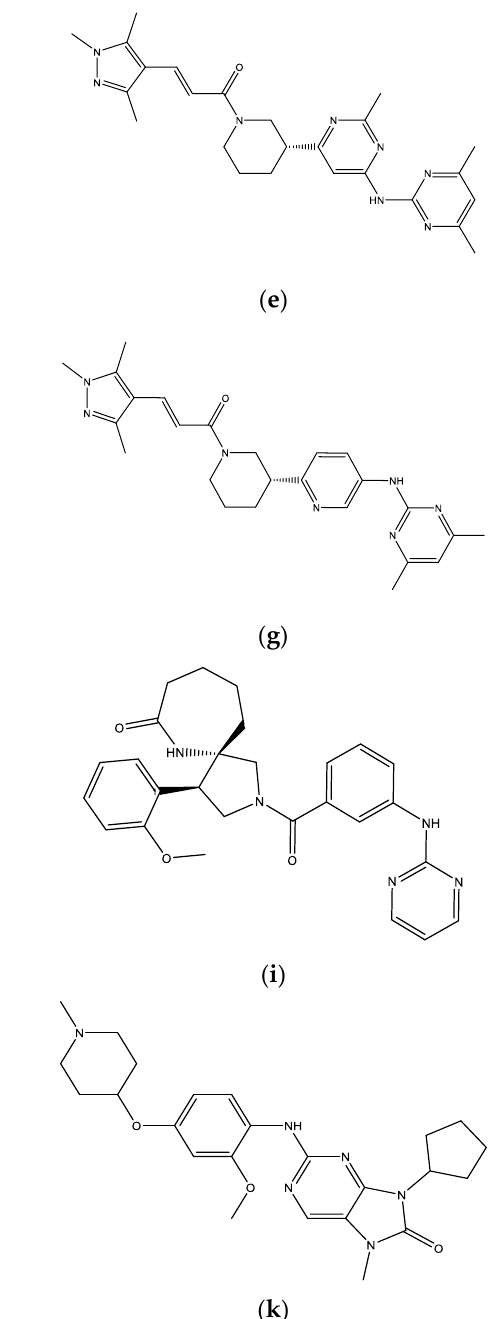
Figure 4. The chemical structures of FDA-approved drugs ( a ) Palbociclib, ( b ) Ribociclib, ( c ) Abemaciclib, and eight hit compounds ( d ) ZINC585292724, ( e ) ZINC585292614, ( f ) ZINC585292587, ( g ) ZINC585291674, ( h ) ZINC585291474, ( i ) ZINC257310160, ( j ) ZINC257203083, and ( k ) ZINC73096242.